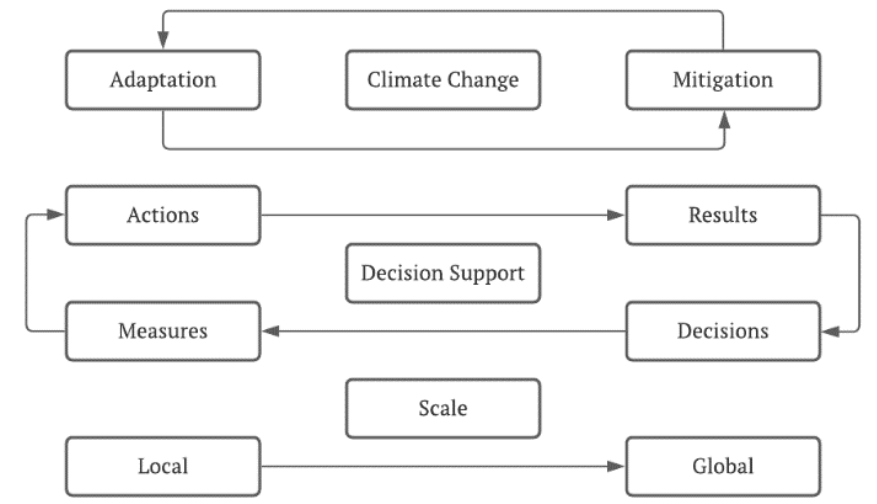
Figure 7. Integration concept of adaptive forest management [63] .